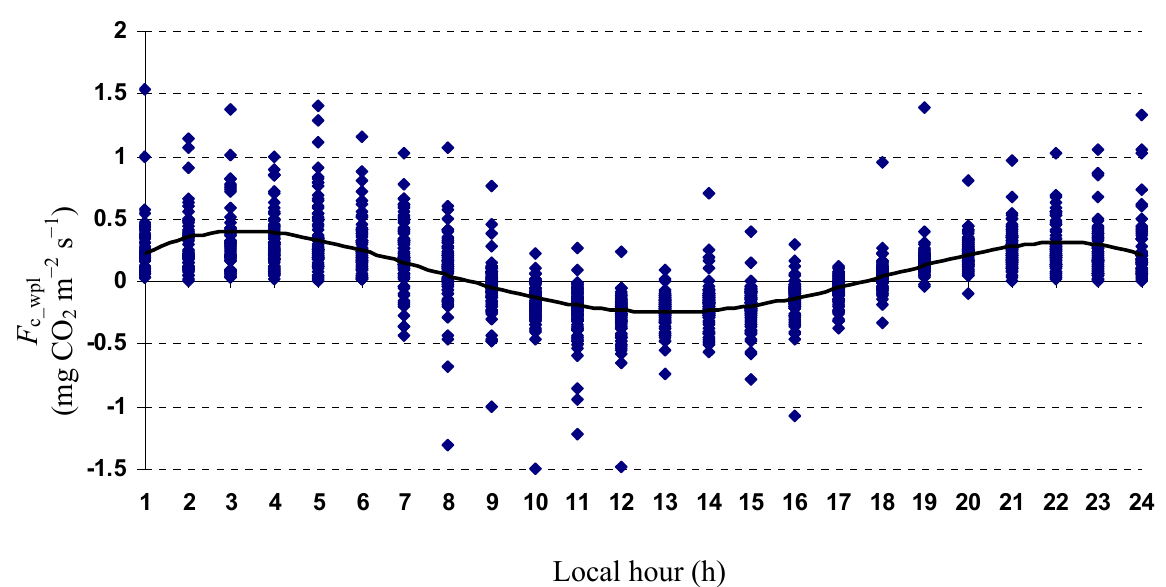
dataset for Yenicaga peatland in July of 2010: c_wpl